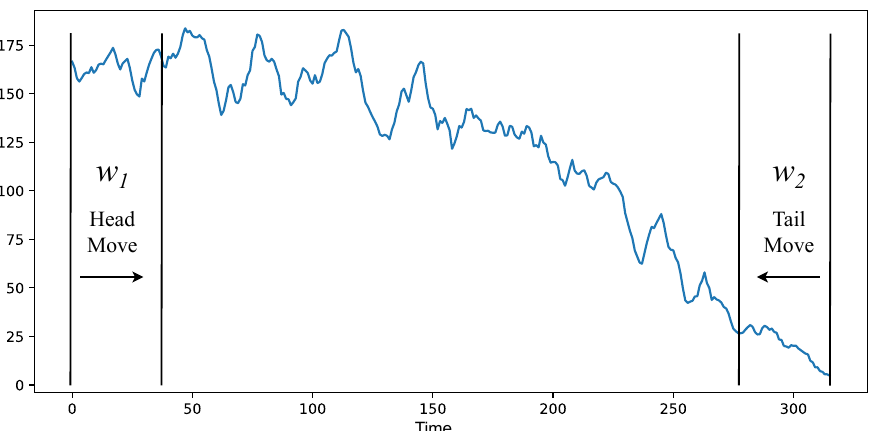
Figure 7. Explanation of HMTM strategy. We see both sliding windows of observation from head and tail are moving towards each